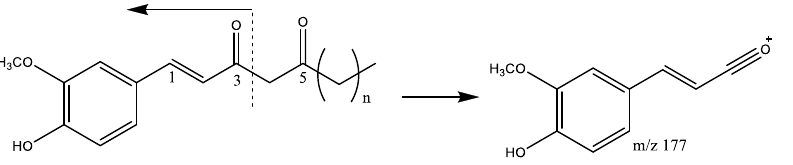
Figure 7. Fragmentation pathway for dehydrogingerdione compounds 19 ( n = 6), 27 ( n = 8), 34 ( n = 10).